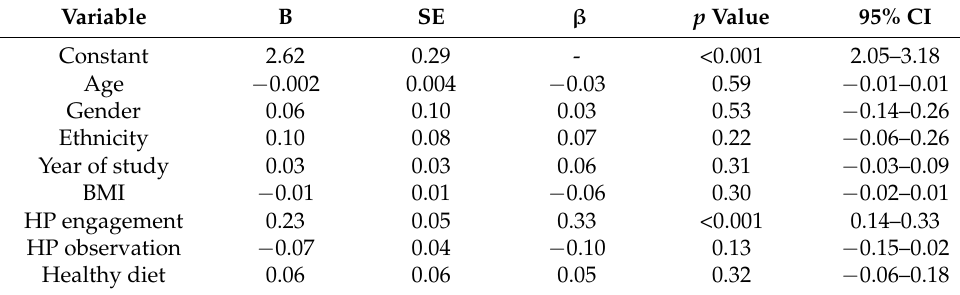
Table 3. Linear regression model predicting RA ( n = 343).